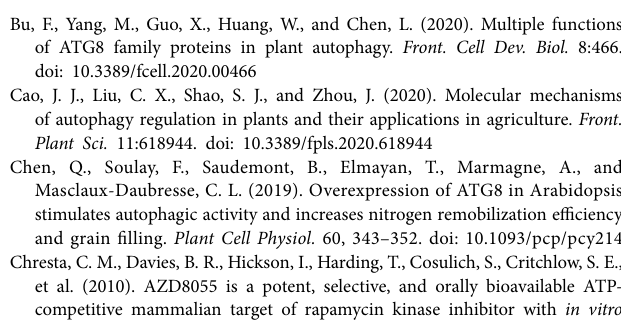
Supplementary Figure S1 | Visualization of accumulation of autophagic bodies in rice protoplasts. Rice protoplasts expressing GFP-OsATG8a driven by (A) UBQ10 promoter, (B) OsATG8a promoter was observed with LSCM after treatment with 200 nM AZD8055 or 1 μ M ConA, or AZD8055 plus ConA, for 3 h. Bar = 7.5 μ m. Supplementary Figure S2 | Verification of GFP and GFP-OsATG8a transgenic lines. T1 transgenic lines regenerated from the transformed rice calli were verified with (A) genomic PCR and (B) immunoblotting. GFP antibody recognizes GFP-ATG8 bands (40 kD) and free GFP (27 kD). (C) GFP-OsATG8a and GFP-OsATG8d from rice transgenic lines (P for plant) or prokaryotically expressed (E for E.coli ) were detected with a GFP antibody. Primers used in (A) are listed in Supplementary Table S1 . Anti-histone H3 was used as an internal control in (B) . Supplementary Figure S3 | Growth parameters of rice transgenic lines carrying GFP-OsATG8a . (A,B) T1 transgenic rice plants grown in the paddy field were measured before harvesting. (A) Plant height and (B) tiller number were measured. Data are means ± SD ( n = 7–15), one-way ANOVA followed by a Duncan test; p = 0.05. Different letters denote significant differences. (C) Phenotypes of 16-day-old transgenic rice seedlings. Three T3 lines for each construct were shown. Bar = 3